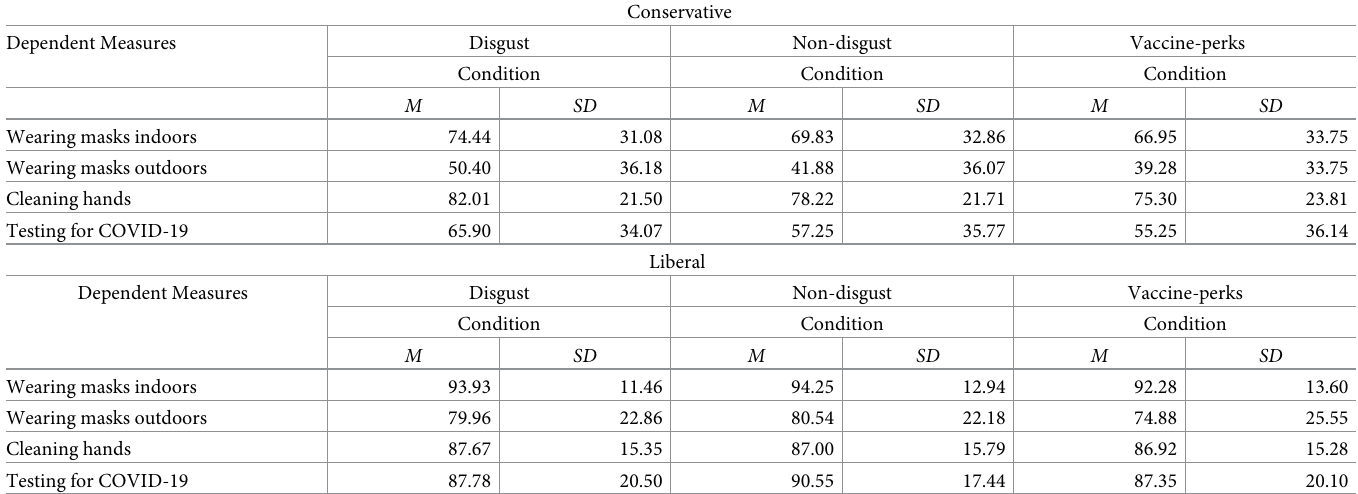
Table 2. Descriptive statistics for the four sets of dependent measures for unvaccinated conservative and liberal participants in each condition in study 2.